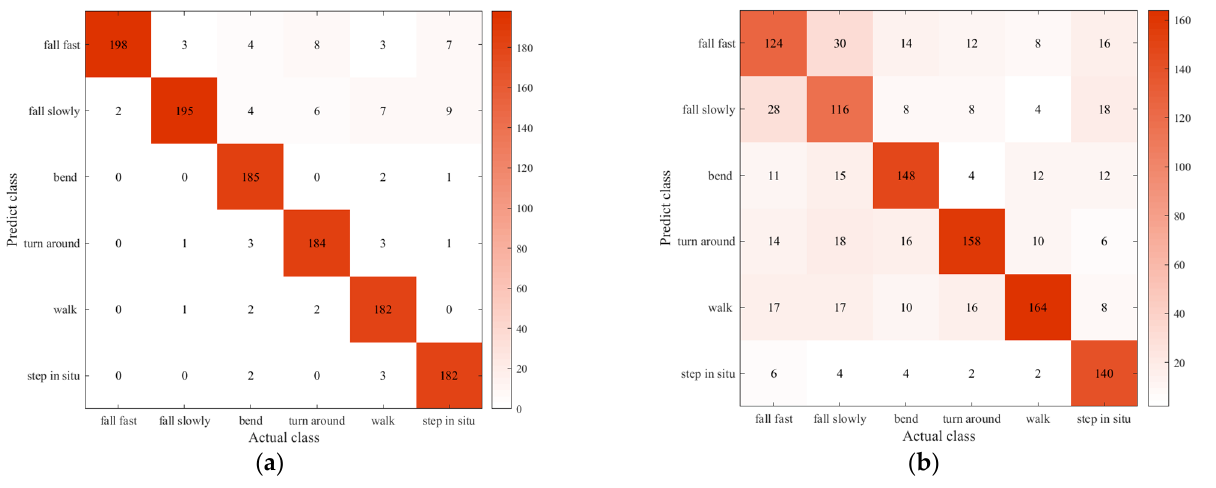
Figure 17. Confusion matrix of classification results from different actions: ( a ) Dual view based Relax mechanism; ( b ) Traditional micro-Doppler spectrum